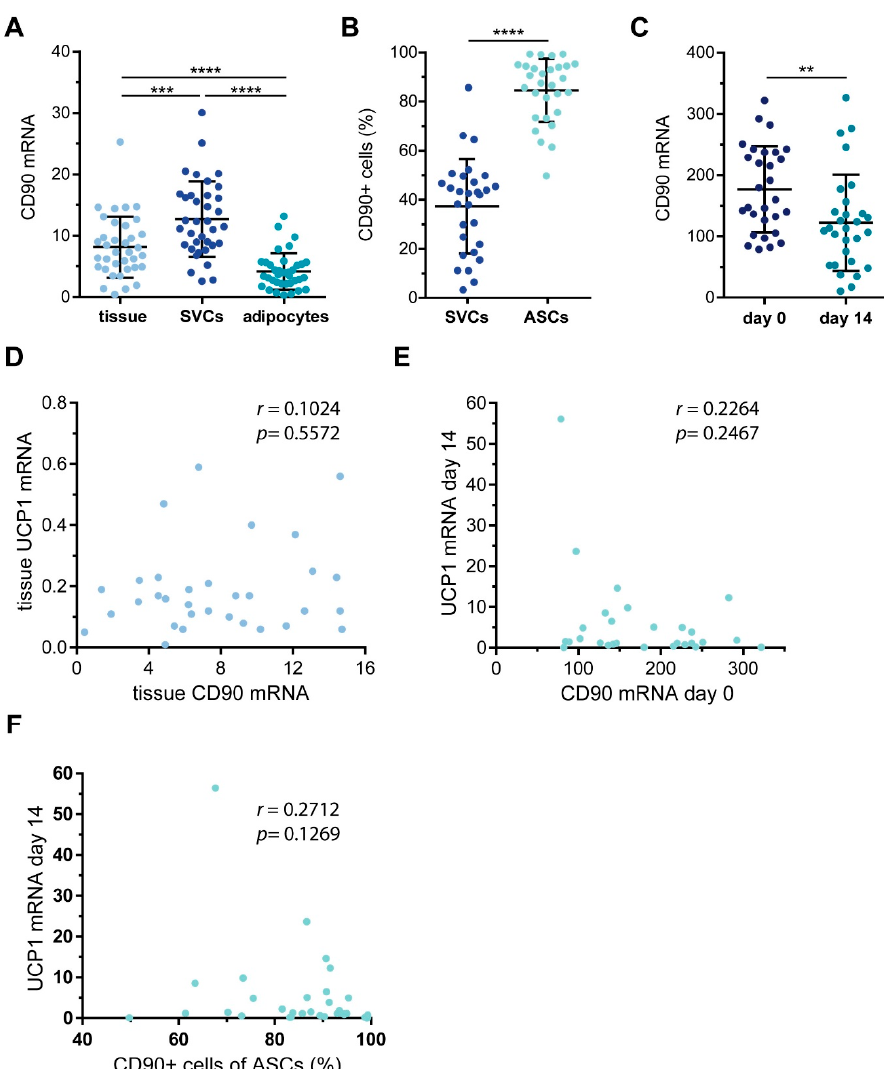
Figure 2. CD90 expression in white adipose tissue (WAT)-derived SVCs and ASCs. WAT samples were obtained from 29 patients undergoing plastic surgery. ( A ) The mRNA expression of CD90 was determined by RT-qPCR in whole tissue as well as isolated SVCs and adipocytes. TF2B expression was used to normalize the data. Data are displayed as mean ± SD. *** p < 0.001, **** p < 0.0001, one-way ANOVA with Tukey correction. ( B ) SVCs and ASCs were analyzed by flow cytometry to quantify the percentage of CD90 + cells. Data are displayed as mean ± SD. **** p < 0.0001, Student’s paired t -test. ( C ) ASCs taken into culture and subjected to adipogenic di ff erentiation. RNA was isolated before adipogenic induction (day 0) and 14 days after (day 14). The mRNA expression of CD90 was determined by RT-qPCR. TF2B expression was used to normalize the data. Data are displayed as mean ± SD. ** p < 0.01, Student’s paired t -test. ( D ) Correlation of WAT mRNA expression of UCP1 and CD90 . ( E ) Correlation of ASC mRNA expression of CD90 and corresponding adipocyte mRNA expression of UCP1 . ( F ) Correlation of ASCs percentage of CD90 + cells and corresponding adipocyte mRNA expression of UCP1 . Spearman correlation coe ffi cient r and p value are given in each scatter